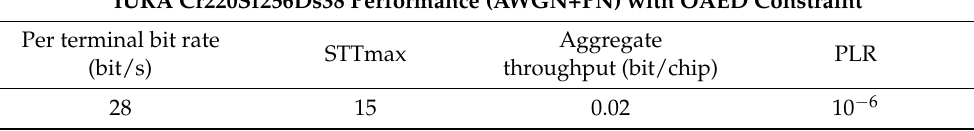
Table 2. UC#2 performance